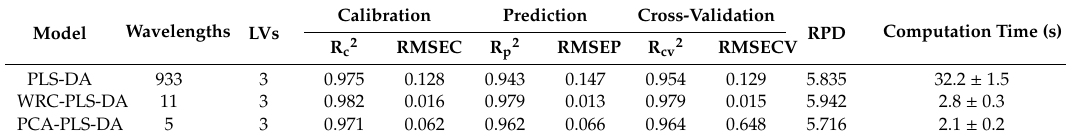
Table 1. Regression performance of models for prediction of particle size fraction of milk powder. Model